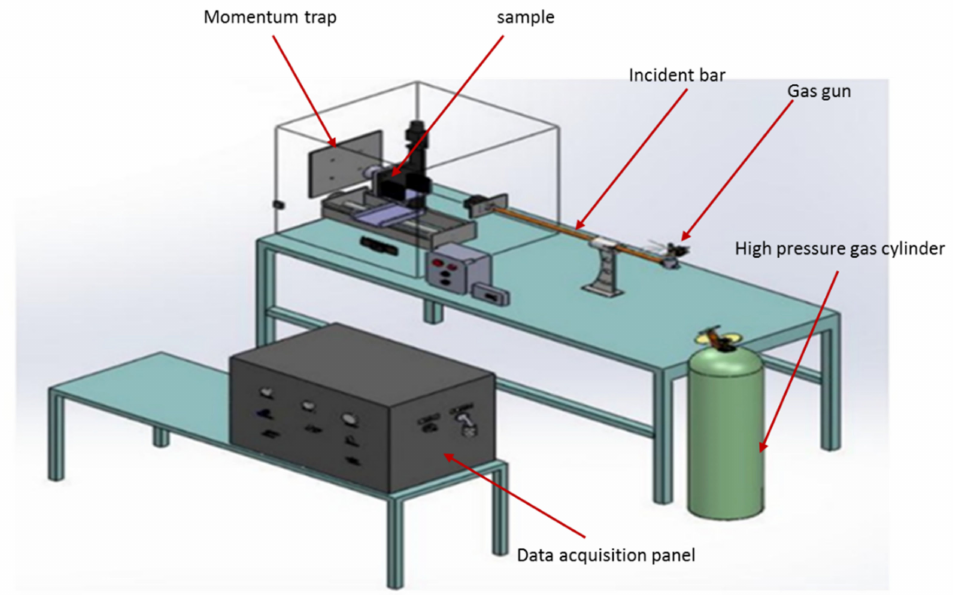
Figure 7. A schematic view of a Split Hopkinson Pressure Bar (SHPB) machine.